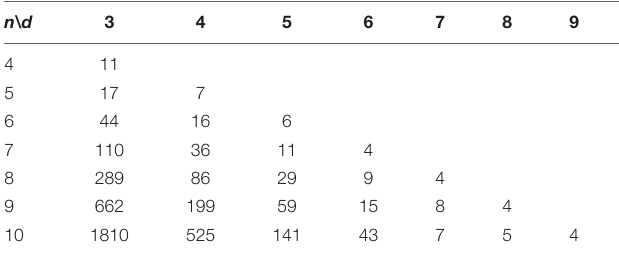
TABLE 6 | Lower bounds of the altruistic algorithm for A GC , NL ( n , d , and w ; Limbachiya et al., 2018).